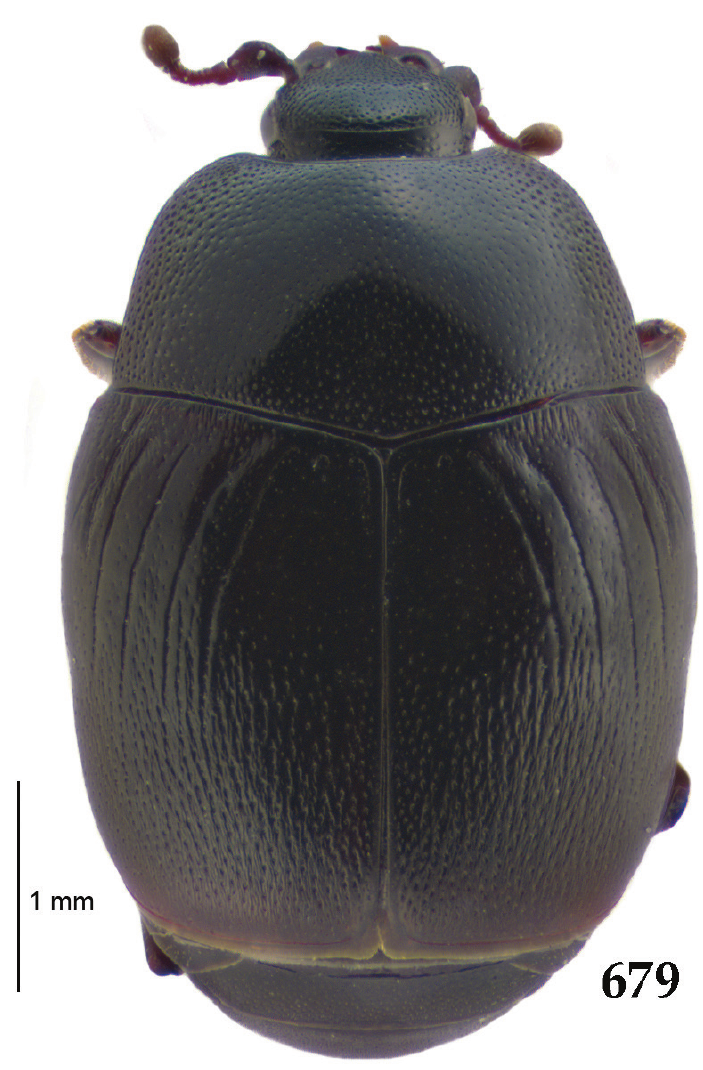
Figure 679. Tomogenius latipes (Broun, 1881) habitus, dorsal view. 5 specs., ditto, but LUNZ; 1 spec., South-East Island, 31.xii.1998, R.M. Emberson (on tree trunks at night) (LUNZ); 1 spec., Kauri Sanctuary, Omauta Forest, N.D., 8.v.1974, G. Kuschel leg. (MNHN, coll. Thérond). Biology. This species was found in nests and surrounding litter of pelagic birds (petrel burrows, nests of Broad-billed prion ( Pachyptila vittata (Forster, 1777)); Sooty shearwater ( Ardenna grisea (Gmelin, 1789)), in the nest of a kingfisher, and in bat guano ( Mystacina tuberculata ). Additional specimens have been collected from moss and lichens, on tree trunks at night and in pitfall